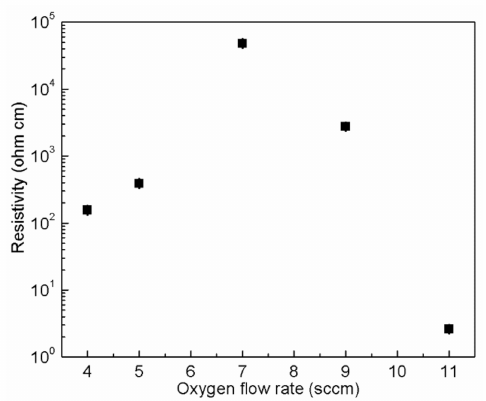
Figure 3. Room temperature resistivity of NiO thin films deposited on glass substrates with different oxygen flow